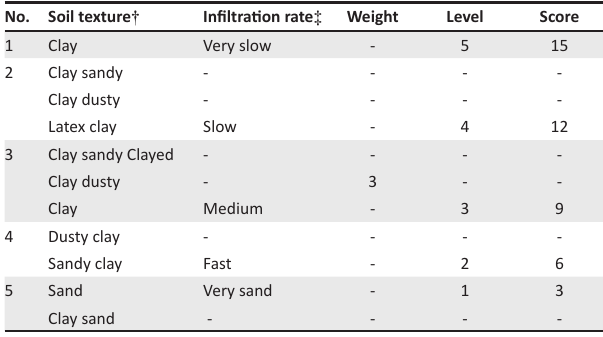
TABLE 3: Soil infiltration classification.